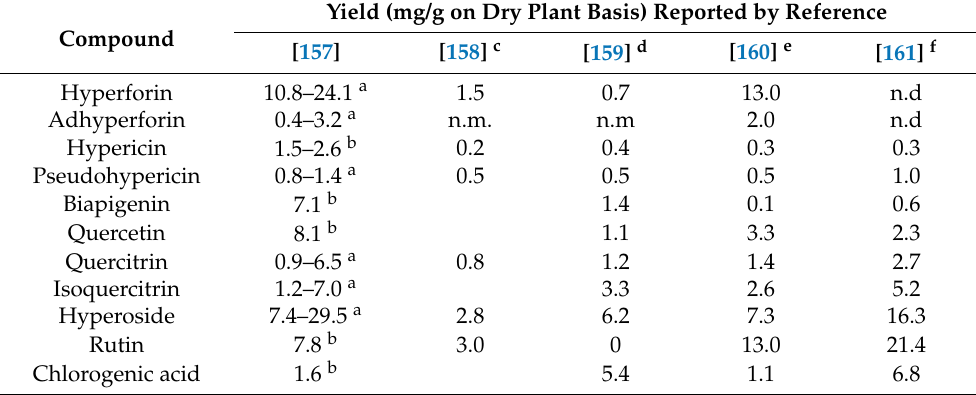
Table 5. Extraction yields of the major constituents of St. John’s wort reported by several investigators. Yield (mg/g on Dry Plant Basis) Reported by Compound